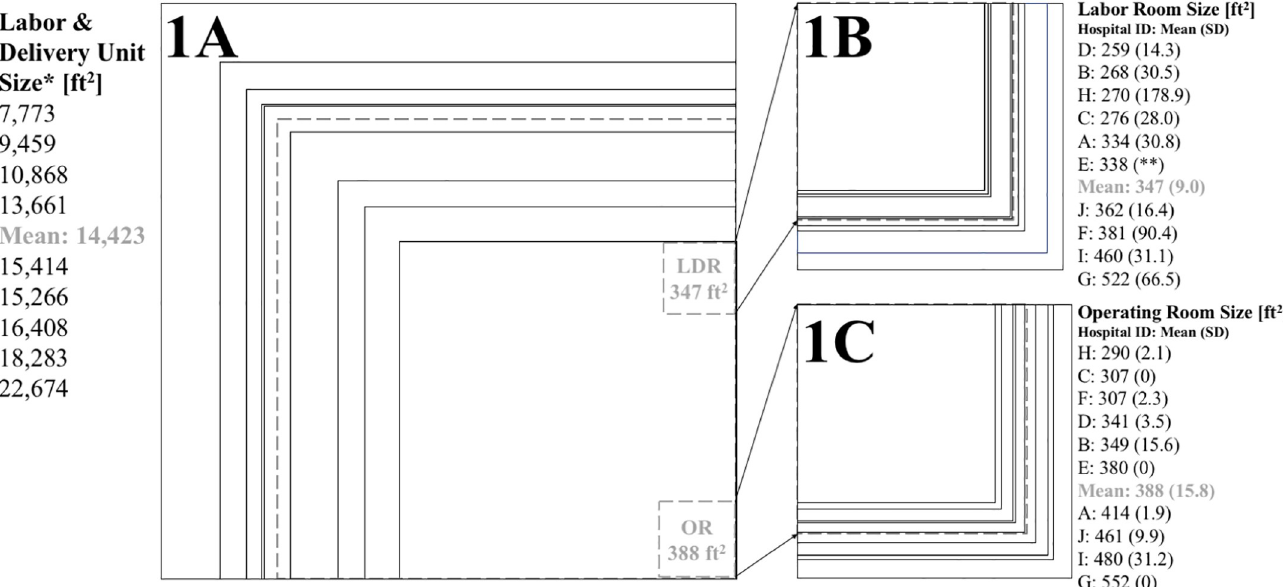
Fig 1. Labor unit, labor room, and operating room size for each hospital. 1A. Labor unit size comparison overlay. Each solid line box represents scaled size (ft 2 ) of a labor unit, including all labor rooms, operating rooms, storage areas, hallways, provider workspaces, and patient and family areas. Provider call rooms and locker rooms were not included. The dashed line box represents the mean square footage of all units. Mean labor room and operating room shown to scale in grey for reference. Nine labor units included because, for hospital E, no blueprints available to measure total unit square footage. � Hospitals listed in ascending order by unit square footage (independent of randomized hospital identification) to protect identity. 1B. Labor room size comparison overlay. Each solid line box represents the mean labor room size (ft 2 ) within a labor unit. The dashed line represents the mean labor room size across units. �� No blueprints available to obtain standard deviation. 1C. Operating room size comparison overlay. Each solid line box represents the mean operating room size (ft 2 ) within a labor unit. The dashed line represents the mean operating room size across units.